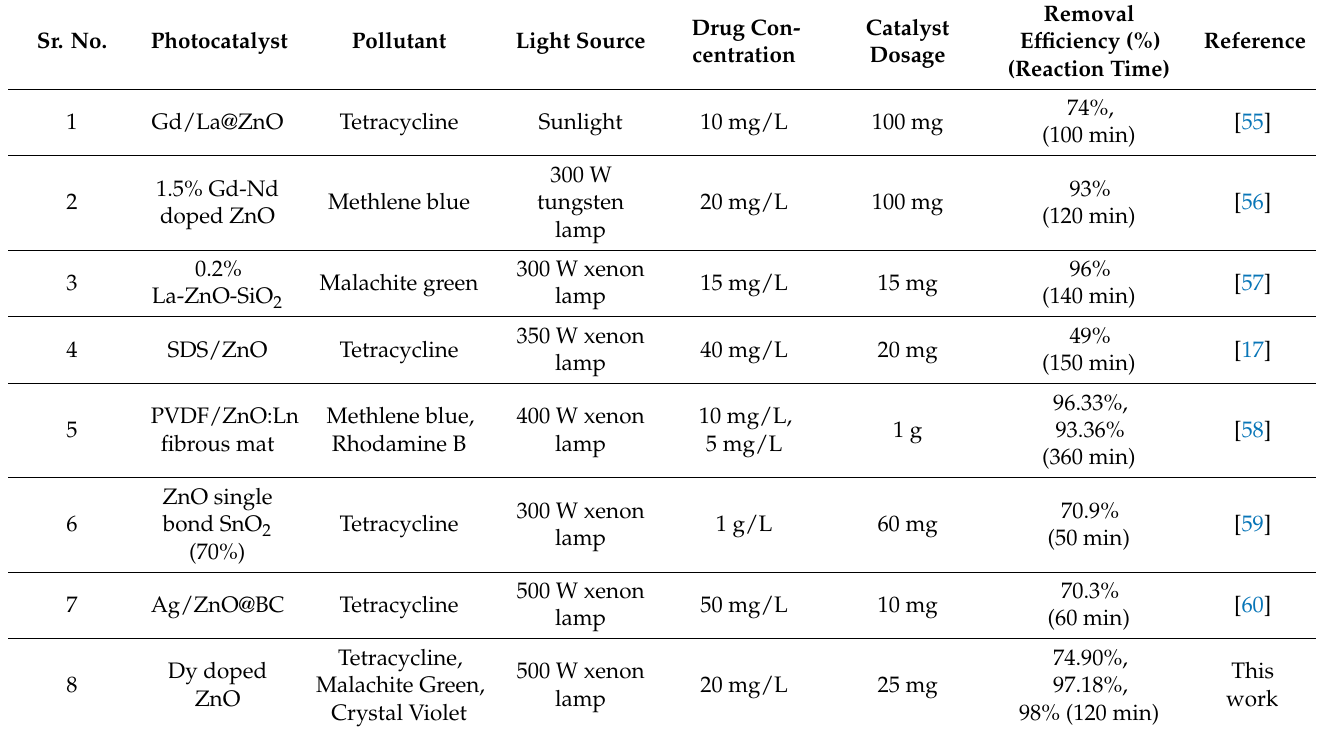
Table 3. Comparison of previously reported work on various pollutants’ degradation using ZnO- based photo